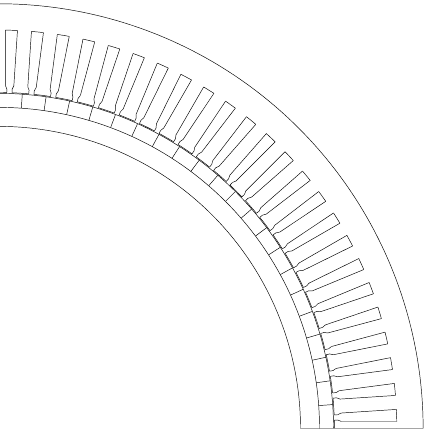
Figure 1. NdFeB SPM motor used as reference motor. Table 1. Main data of the reference SPM